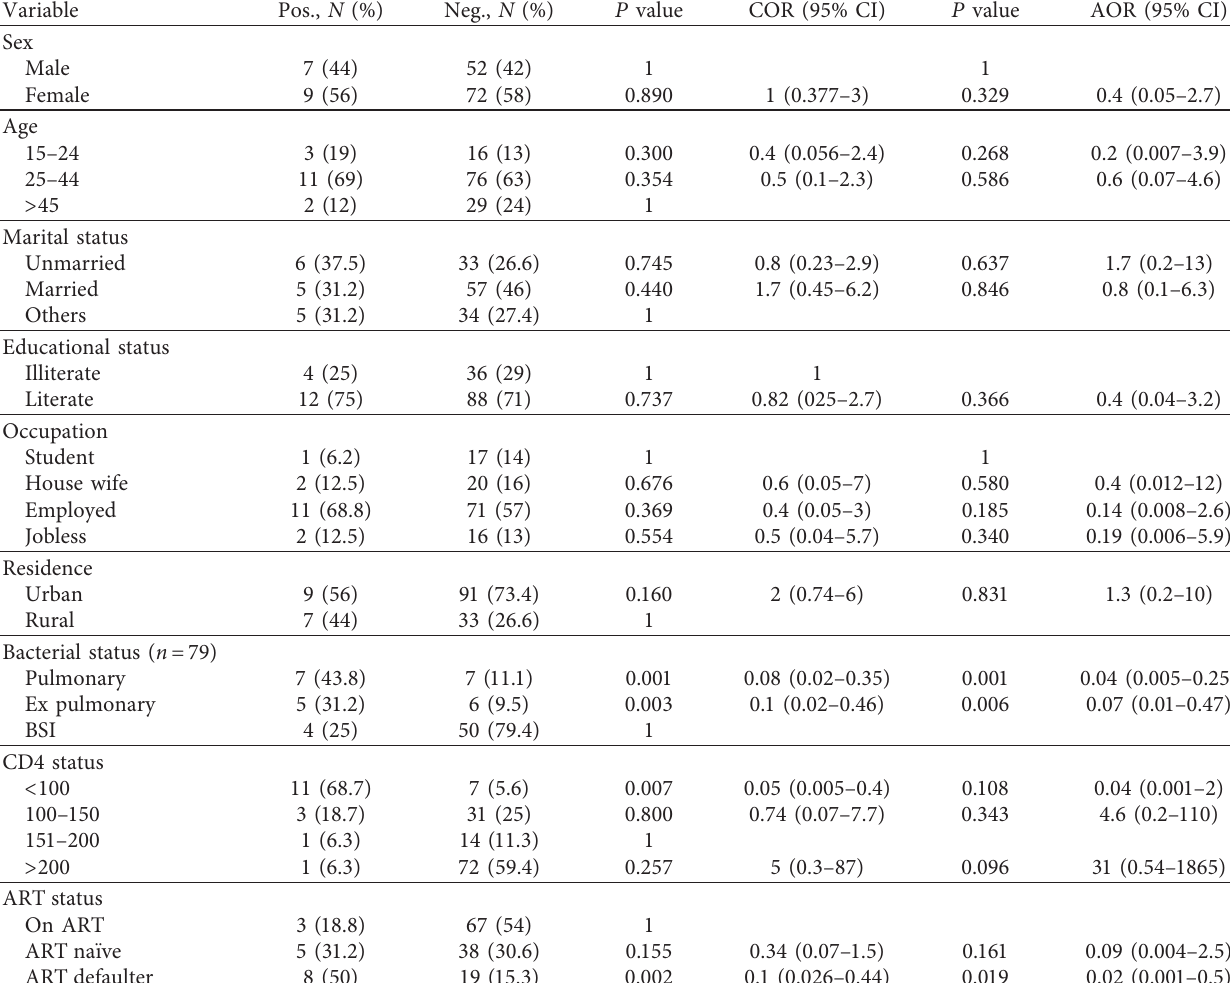
Table 2: Bivariate and multivariate analysis of factors associated with serum cryptococcal antigenemia among HIV/AIDS patients in Felege- Hiwot Referral Hospital, Bahir Dar, Ethiopia.